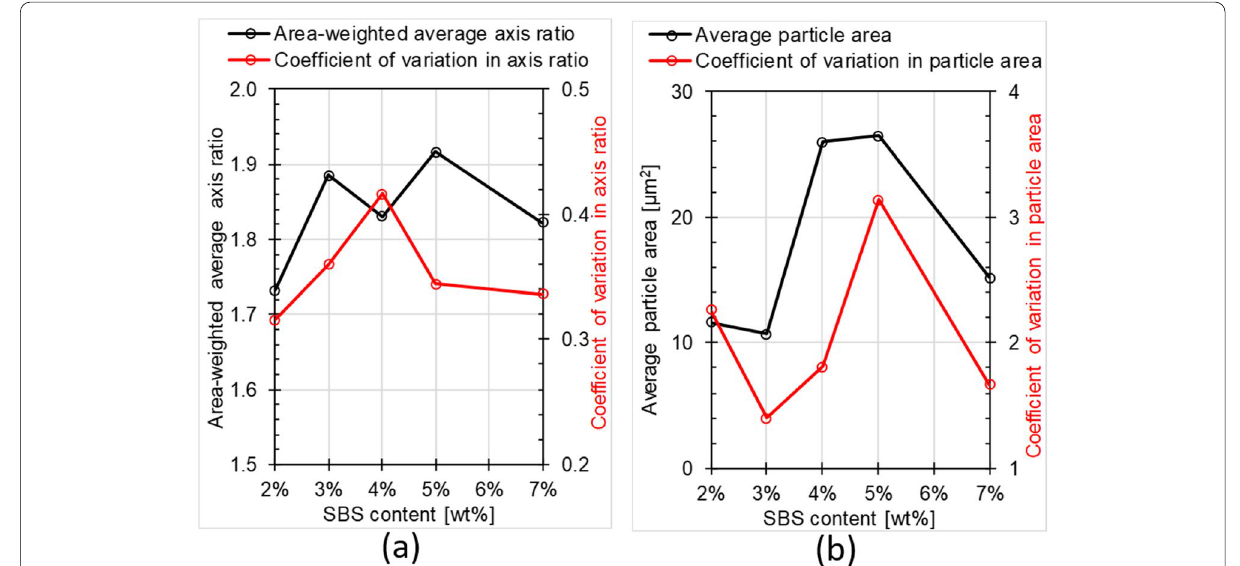
Fig. 7 Influence of SBS content on the axis ratio ( a ) and particle area ( b ) in